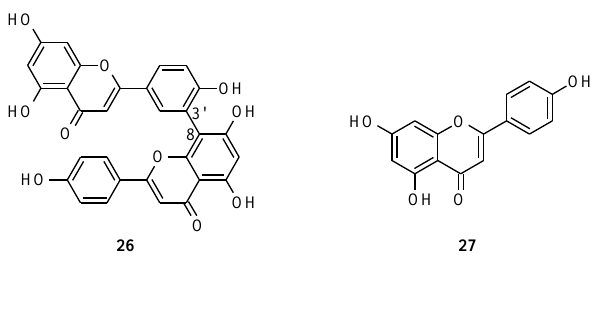
Figure 3. Structures of amentoflavone and its